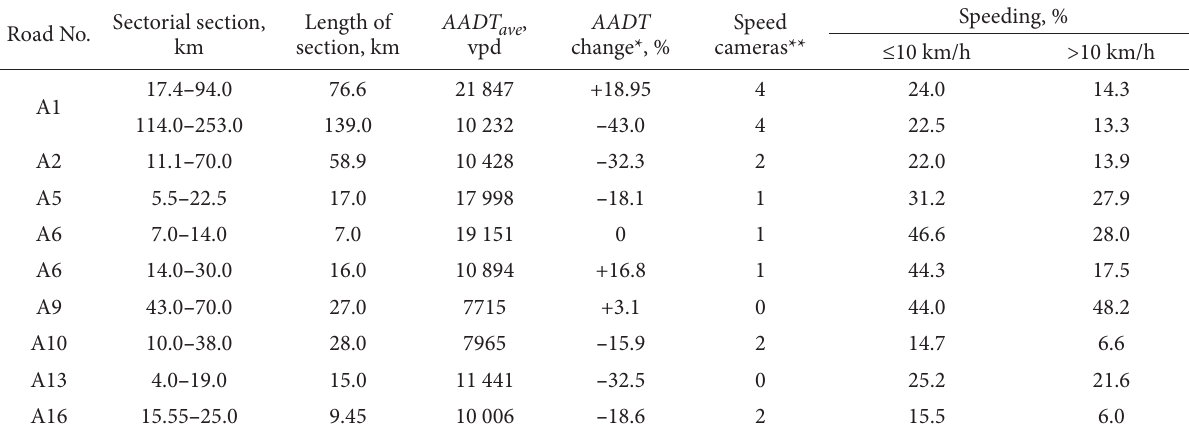
Table 2. Traffic data of road sections selected for the installation of a sectorial speed enforcement system Sectorial section, Road No.